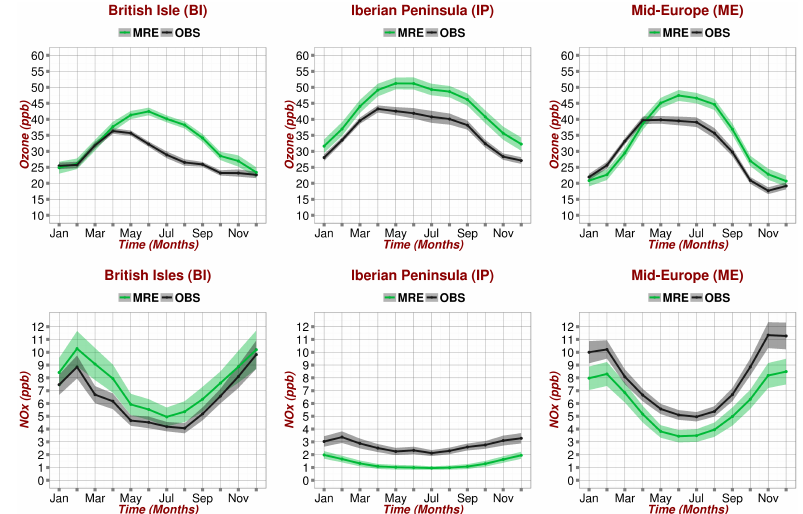
Figure 9. Mean annual cycle of near-surface O 3 (top panel) and NO x (bottom panel) based on observations (solid black line) and MRE (green line) for the subregions BI, IP, ME over the period